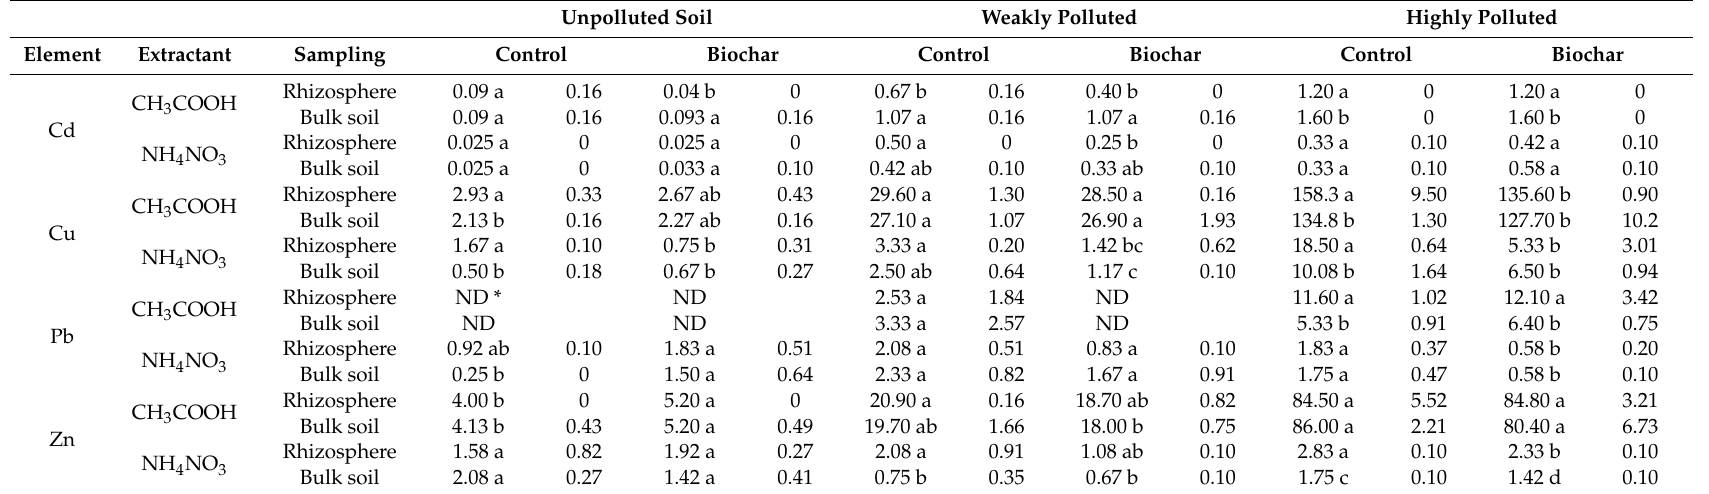
Table 6. Metal concentrations (mg / kg and SEM values) in extracts from rhizosphere soil and bulk soil from a pot experiment with barley, and the e ff ects of biochar (2% by weight).